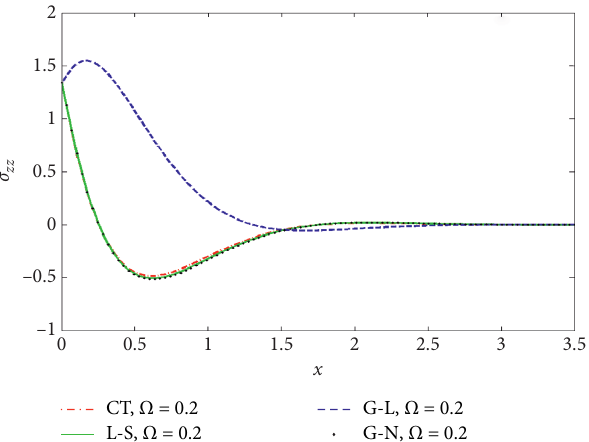
+ σ zz zz concerning